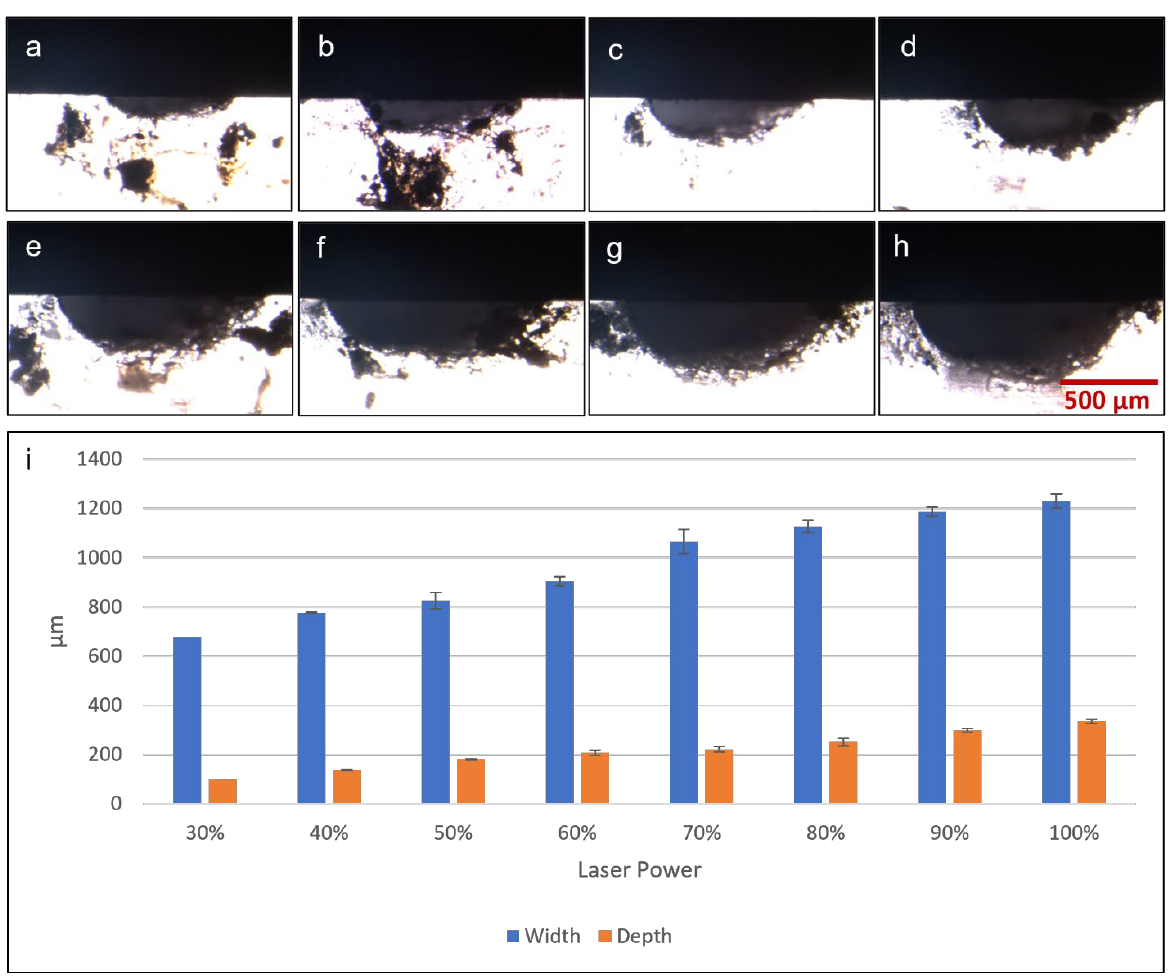
Figure 6. Microscopic photographs of microchannel cross-sections fabricated by diode laser with the following laser power: ( a ) 30%/480 mW, ( b ) 40%/640 mW, ( c ) 50%/800 mW, ( d ) 60%/960 mW, ( e ) 70%/1120 mW, ( f ) 80%/1280 mW, ( g ) 90%/1440 mW and ( h ) 100%/1600 mW. ( i ) Graph showing results of microchannel cross-section dimensions (width and depth) measured from microscopic photographs.